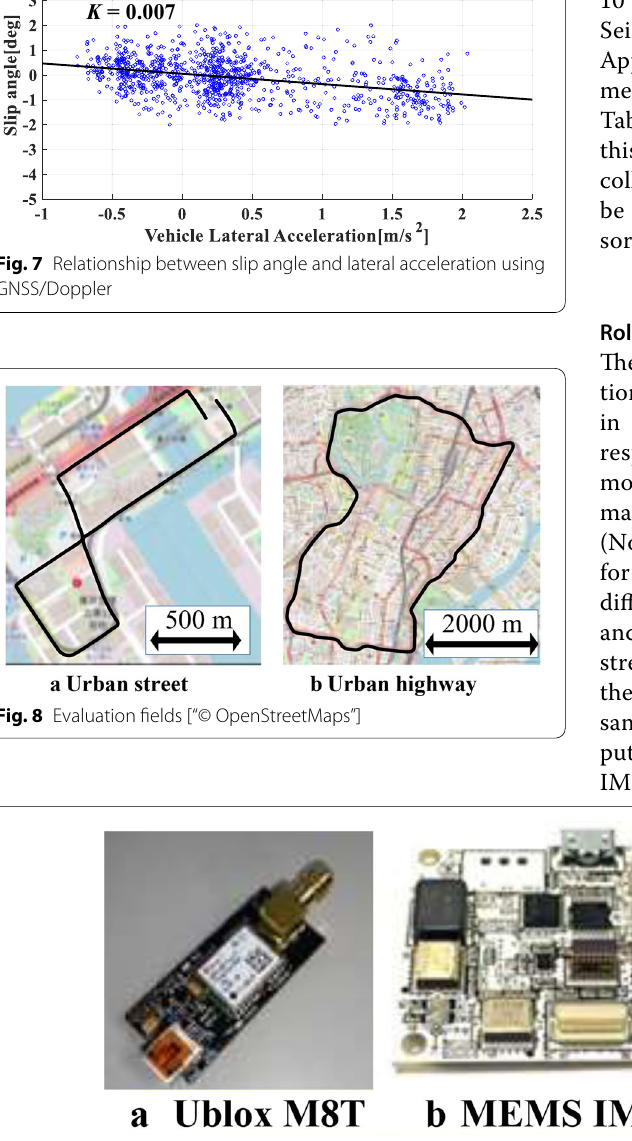
Fig. 9 Photographs of the sensors and the system